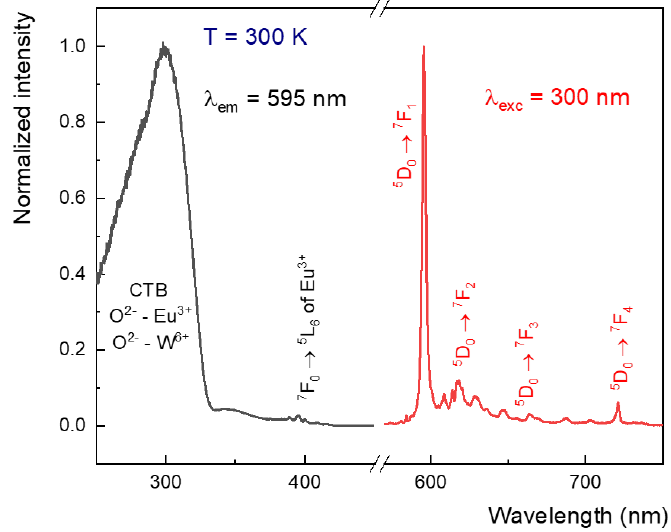
Figure 6. The excitation (black) and emission (red) spectrum of BMW:Eu ceramic materials sintered at 1 GPa and 500 °C.